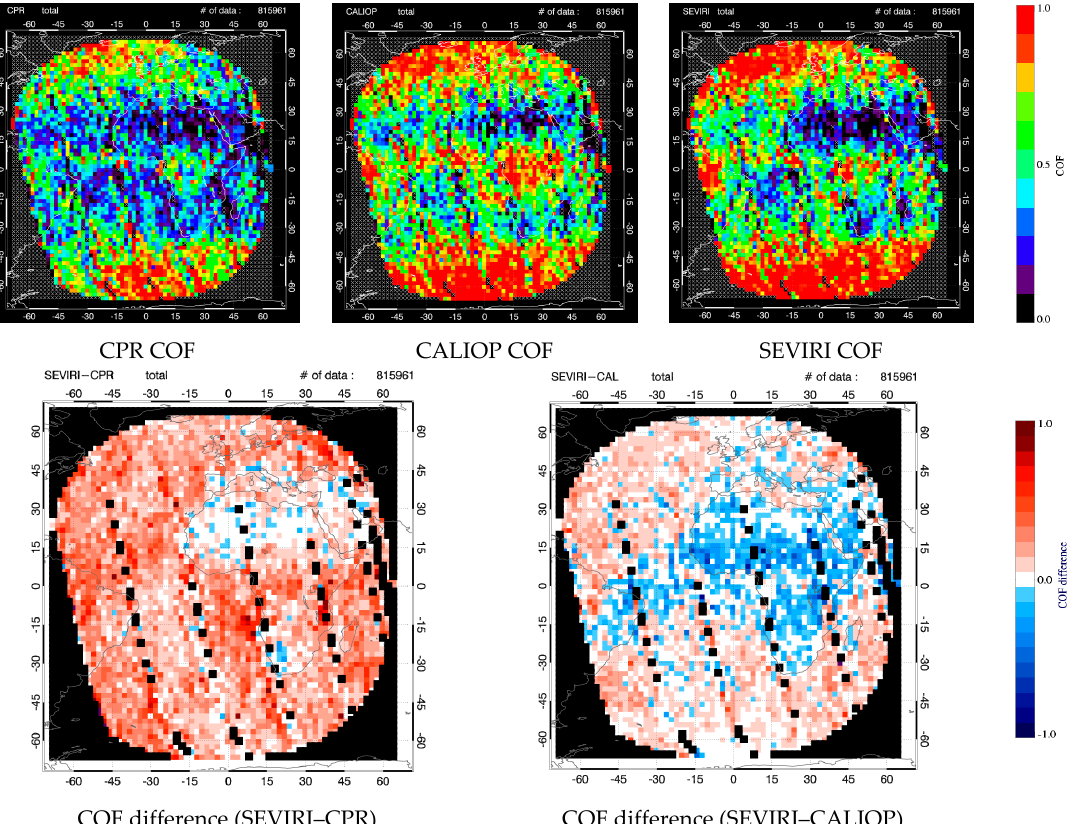
Figure 1. Cloud occurrence frequency maps for Cloud Profiling Radar (CPR), Cloud-Aerosol LiDAR with Orthogonal Polarization (CALIOP), and Spinning Enhanced Visible and Infrared Imager (SEVIRI; upper panels) and the difference maps of SEVIRI compared with CPR and CALIOP products (lower panels) for a one year comparison period between May 2013 and April 2014. The brightness and the colours represent averaged values over a 2° latitude × 2° longitude grid box.